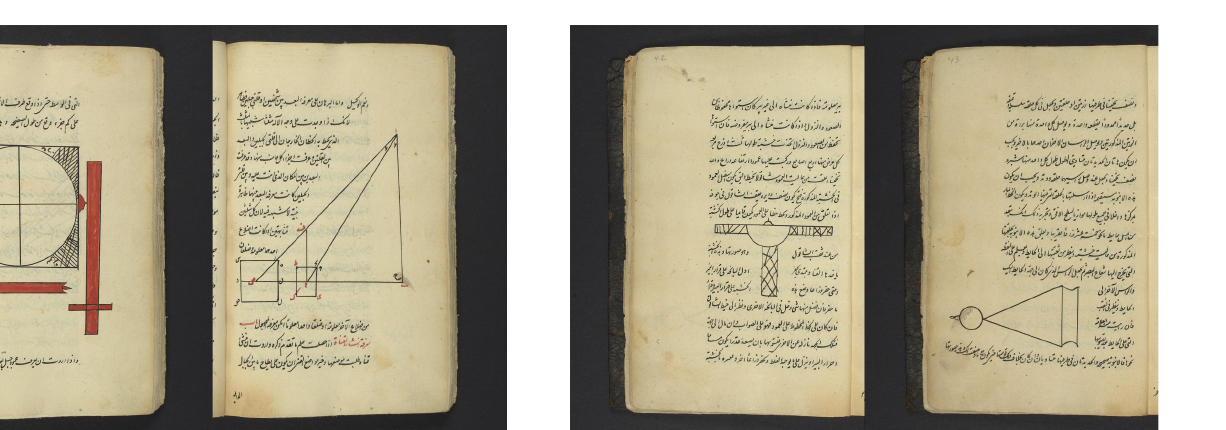
Figure 8. Illustration of the apparatuses for checking the straight- ness of the qanat’s tunnel and sighting tube for qanats. Dia- gram f42r and f43r from Karaji (1675). Permanent link: http://hdl. library.upenn.edu/1017/d/medren/9948256513503681 (last access: 29 July